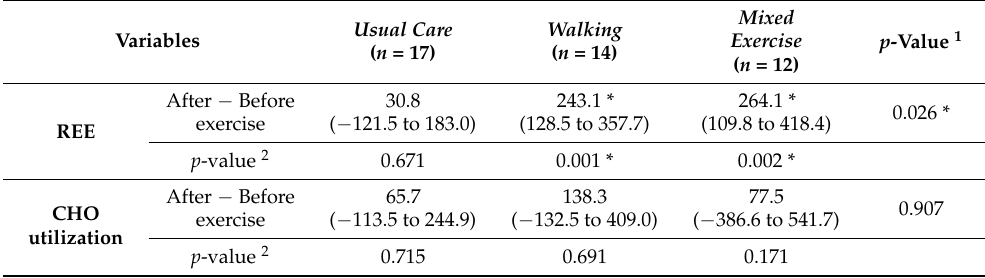
Table 6. Difference in the REE (kcal/d) and CHO energy utilization (kcal/d) of participants in each arm, before and after the interventions †